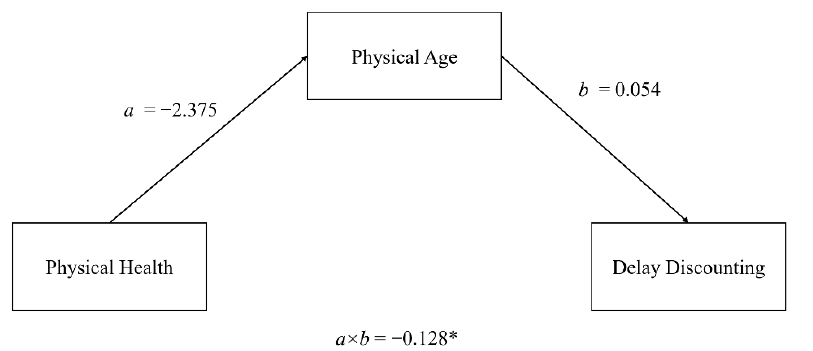
Figure 3. Mediation effects of subjective physical age between physical health and delay discounting. Only the indirect effect was tested. * p < 0.05.